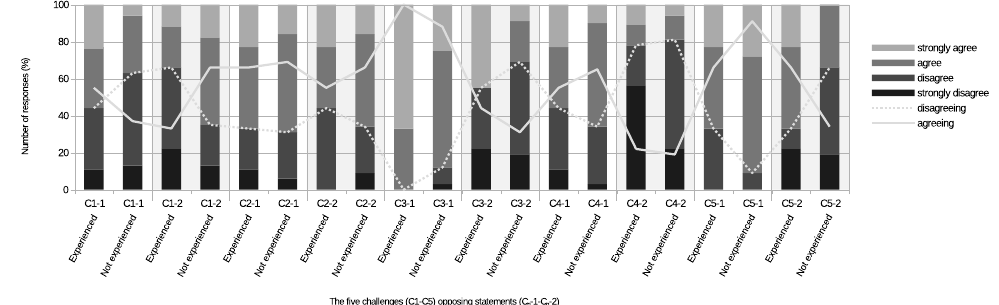
Figure 3. Percent stacked bar chart to show the differences towards the characteristics of identified solutions to the five challenges of agile risk management, aggregation of all respondents filtering on